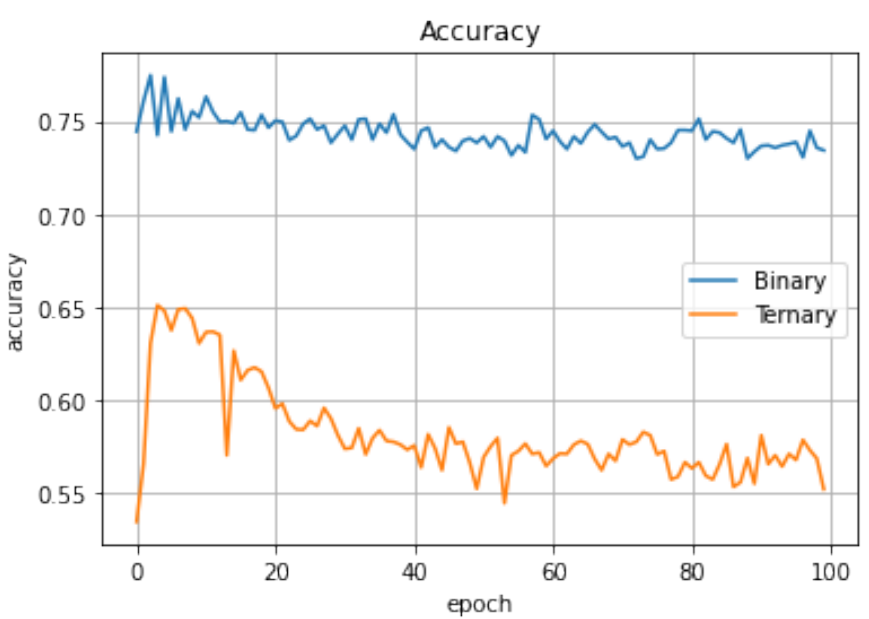
Figure 7. Validation accuracy comparison of binary and ternary classification on the RUSA-19 Dataset. The graph clearly depicts that binary classification outperformed the ternary classification.